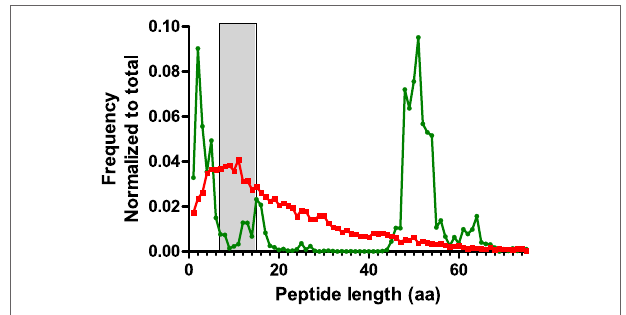
FigUre 8 | Length distribution of tryptic peptides encompassing the CDR3 region obtained by in silico digestion of reads combined from all samples (green). The NGS data were appended with rat IgG2B sequence in order to include the first tryptic site located in the CH1 domain. For comparison, a similar digestion was performed on the human subset of the Uniprot protein database (red). The peptide size range that is optimal for shotgun proteomics analysis (7–15aa) has been highlighted in